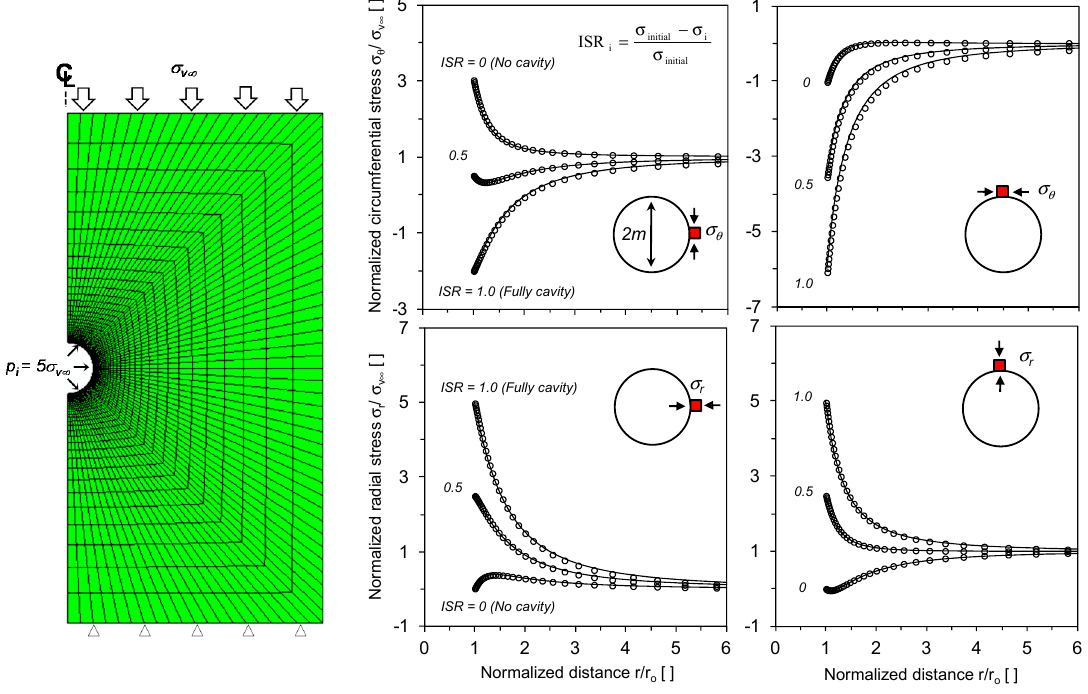
Figure 2. Internal stress relaxation (ISR) module—code verification (solid lines indicate the close-form solution; points are numerically computed values). σ initial is initially stress around the circle zone and σ i is internal stress at the i th step. Results are plotted in dimensionless form. Y axis (stress) is normalized by imposed stress at boundary (far-field stress σ v ∞ ). X axis is normalized by distance from the cavity side.